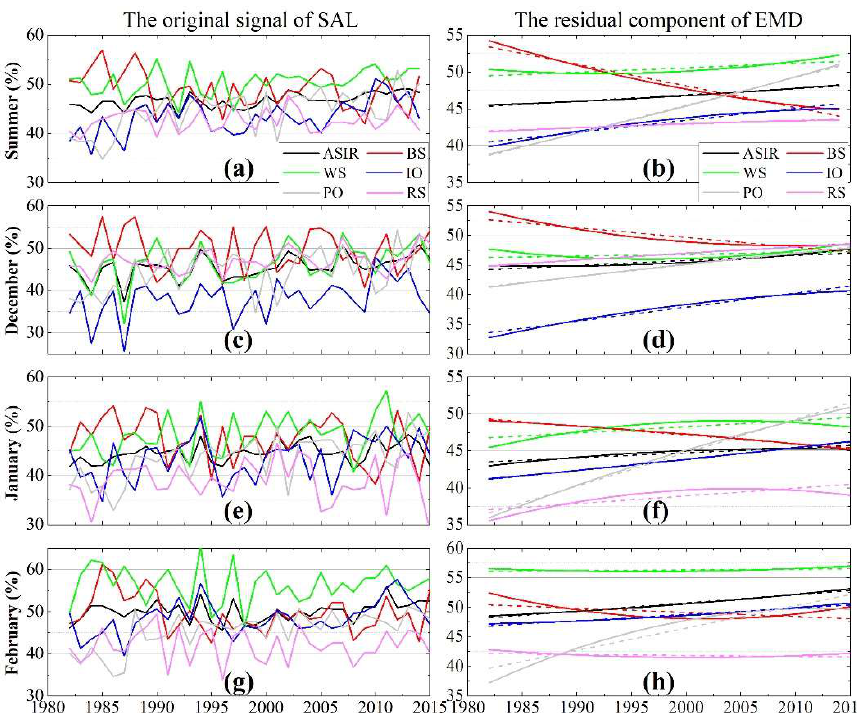
Figure 3. Time series of the averages of SAL (%) during summer ( a , b ); December ( c , d ); January ( e , f ); and February ( g , h ) provided by the CLARA-A2 dataset for the ASIR and the five longitudinal sectors. The left and right columns represent the original signal and residual components, respectively. The dashed lines in the right column refer to the linear fitting lines.